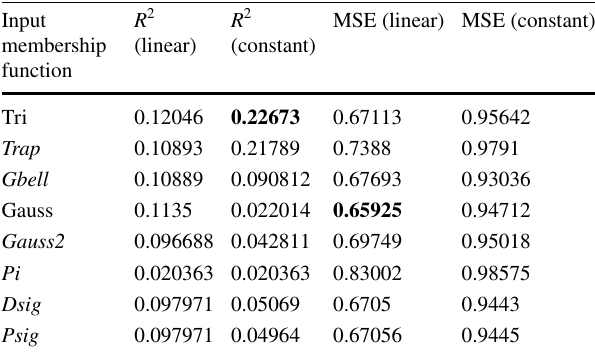
Table 12 ANFIS model efficiency for vanadium (V) removal using LAC